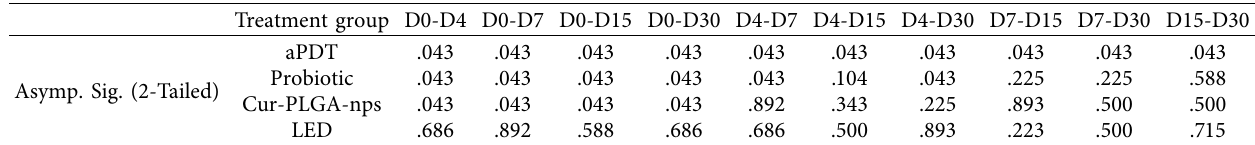
Table 3: Results from pairwise comparisons of CFU/mL of S. mutans between the time points with each other, within each of the treatment groups separately based on the Wilcoxon signed ranks test.